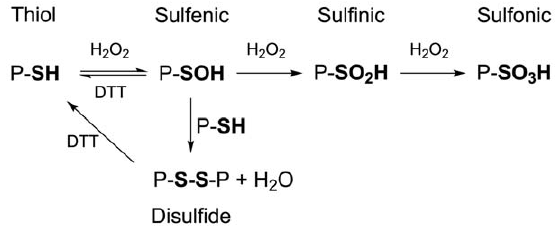
Figure 1. Oxidation states of protein cysteines, and their reversibility by DTT. Schematic diagram showing steps involved in hydrogen peroxide-induced oxidation and DTT-induced reduction of protein cysteines.